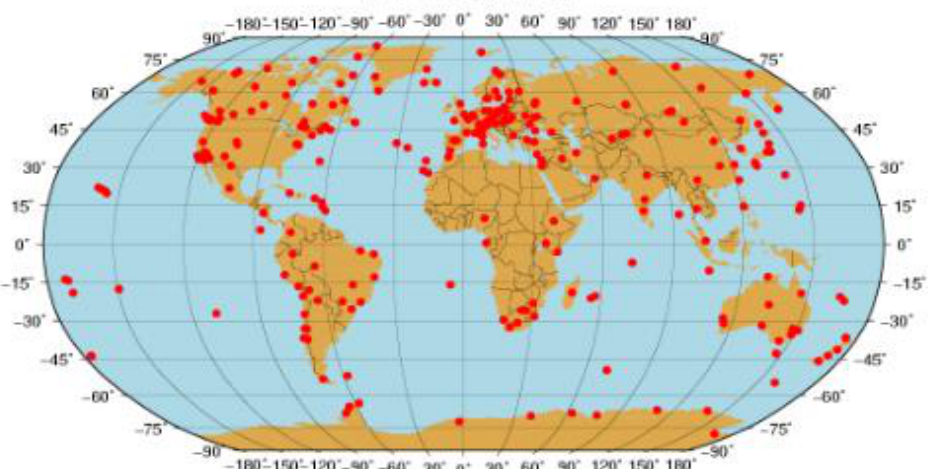
Figure 2. The distribution of the 300 IGS sites used.